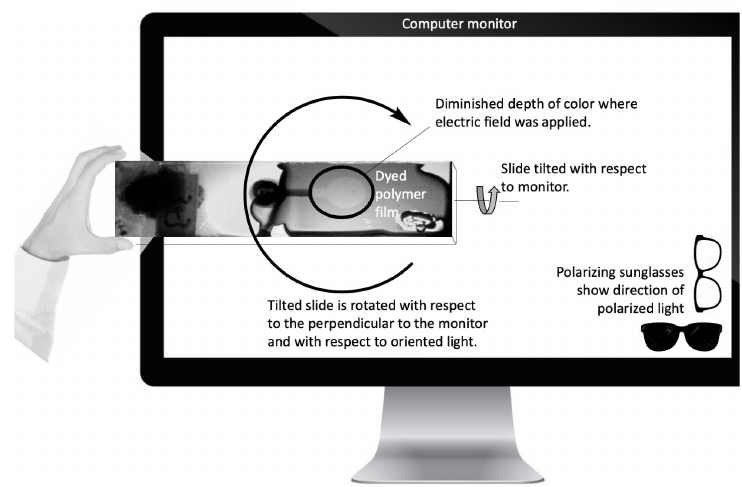
Figure 4: Electro-optic film of the kind expected to “dominate the 21st century” 46 by virtue of orienting dyes, held in front of horizontally polarized light emitted from a computer monitor. The orientation of polarizing sunglasses can be used to assay the direction of the light polarization. Tilting the film with respect to the flat screen, and then rotating it around a perpendicular axis was expected to change the depth of transmitted color active region within the black circle where the electric field was applied. This area was always lighter, and of a different color hue, suggesting chemical degradation and transformation caused by the applied electric field. 75,78 The eye is a very sensitive light detector. No detectable change in color depth upon reorientation of the sample with respect to the monitor means few molecules were oriented. In all samples we investigated, there was obvious decomposition and no change in appearance upon rotation. Curiously, we have never seen a photograph (as exemplified above) in any UW publication of the kinds of samples that we were able to acquire. In all samples that BK investigated, the region of interest was always lighter and not evidently responsive to polarized